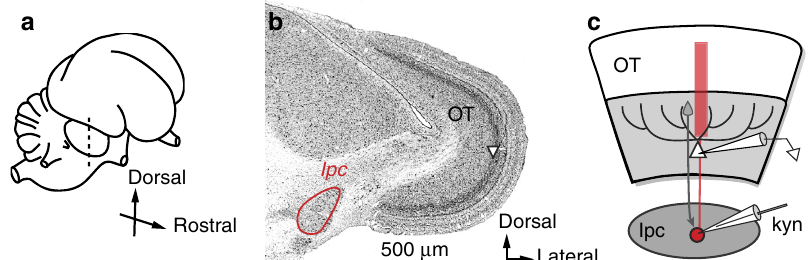
Figure 1 | Experimental set-up. ( a ) The drawing depicts the owl brain and plane of section. ( b ) Nissl-stained, transverse section of midbrain showing the OT and nucleus Ipc (outlined in red). Layer 10 in the OT is indicated by the triangle. ( c ) Schematic of the experimental set-up: extracellular recording electrode in layers 11–13 and multi-barrelled iontophoretic and recording electrode in the Ipc. The drawing represents an ‘aligned’ pair of OTand Ipc sites. Red: cholinergic neuron; shaded portion of OT: deep (multimodal and motor)